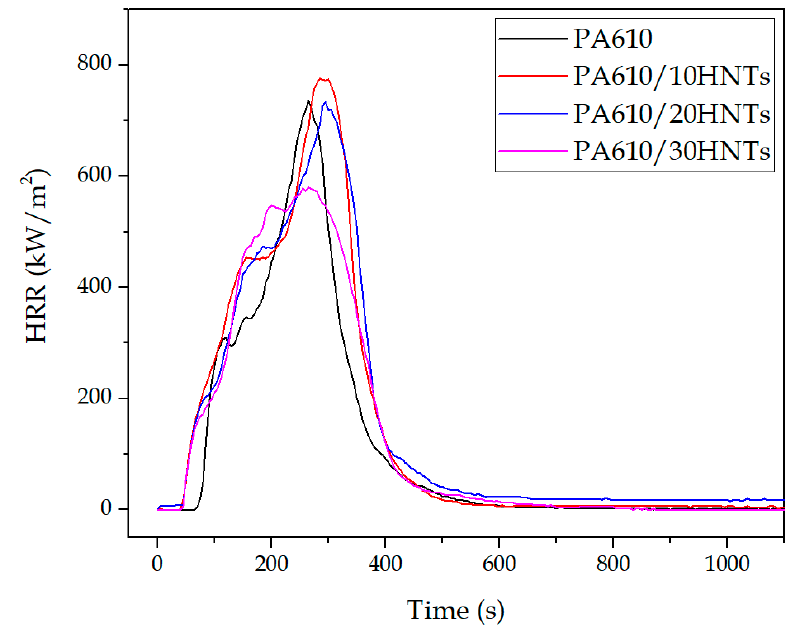
Figure 1. Heat release rate as a function of time.